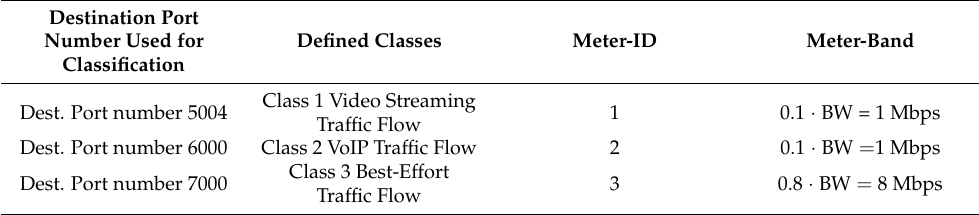
Table 9. Scenario 2 Initialization Phase.